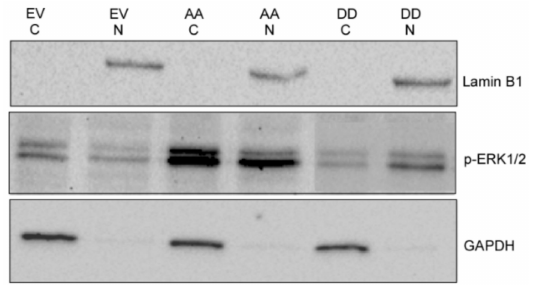
Figure 2. A representative Western blot of phosphorylated extracellular signal-regulated kinase1 / 2 (p-ERK1 / 2) expression in nuclear and cytosolic fractions of the SKOV-3 cells transfected with empty vector (EV), PEA-15AA (AA) and PEA-15DD (DD). GAPDH and Lamin B1 were used as the markers and loading controls of cytosolic (C) and nuclear fractions (N), respectively.